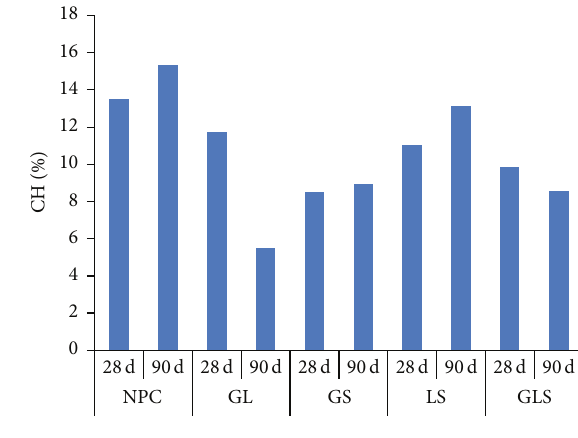
Figure 6: Ca(OH) 2 content of